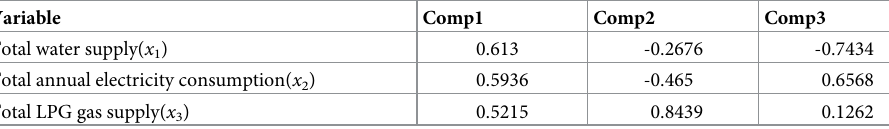
Table 3. Eigenvectors of the 3 principal resource consumption components.